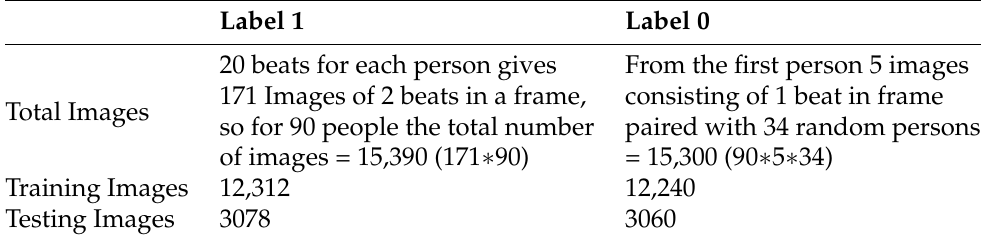
Table 4. Description of the number of training and testing patterns with two beats as a single image.